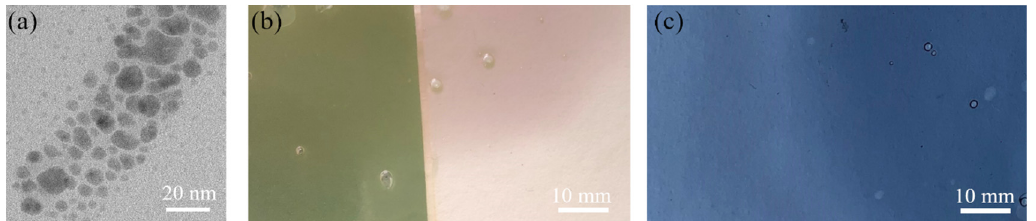
Figure 7. TEM image of small and irregular AgNPs, and AgNPs of quantum dots size ( a ); the thin layer of polymer composite with incorporated dichroic AgNPs (from left to right: reflected and transmitted light) ( b ); and triangular nanoparticles incorporated into PVA matrix ( c ).